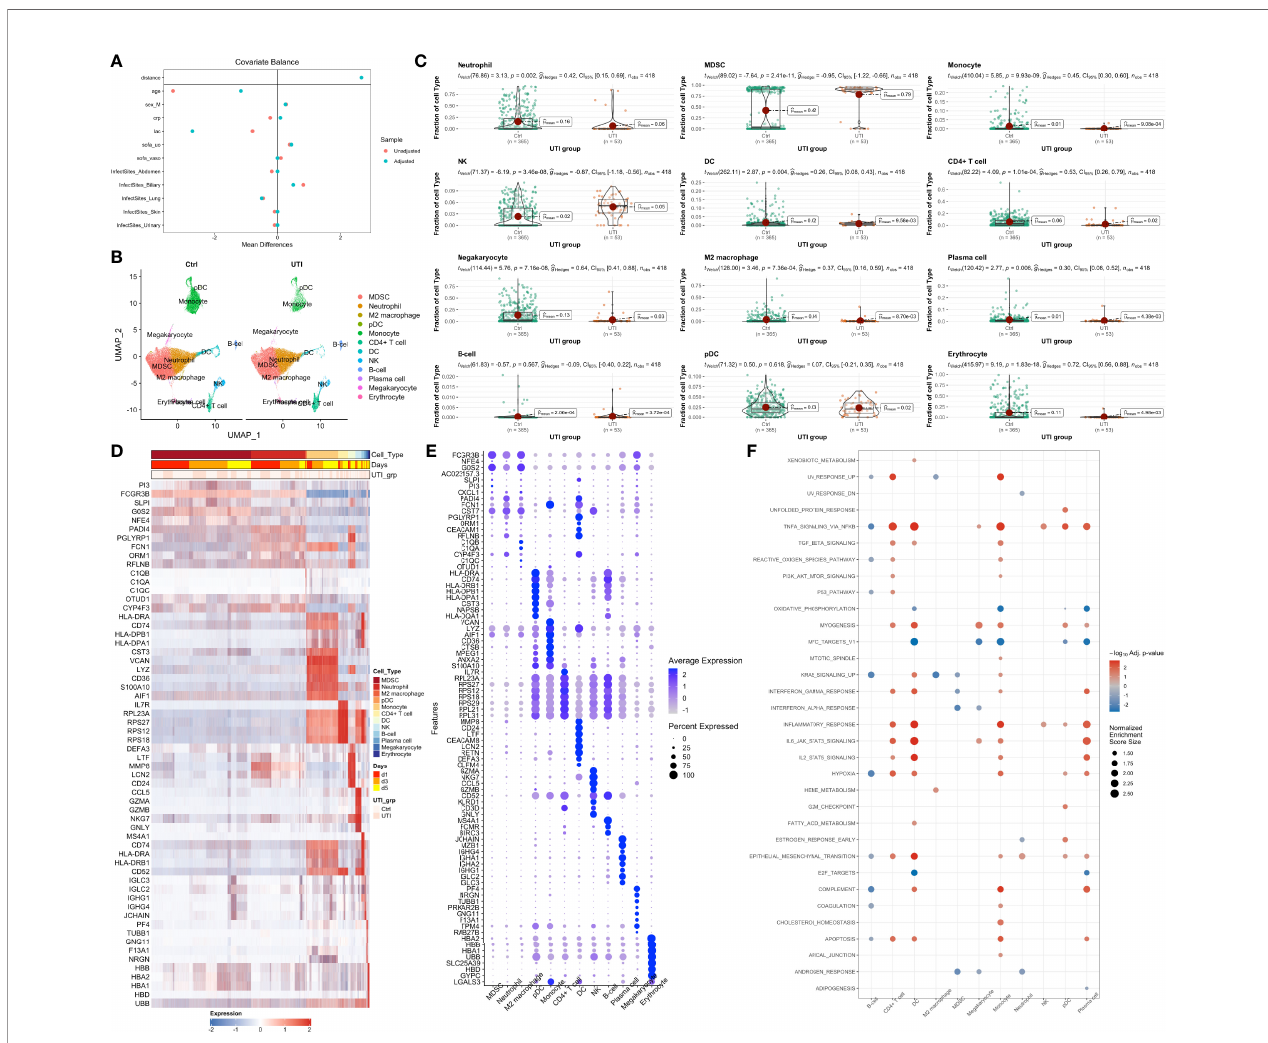
FIGURE 5 | Single cell RNA-seq analysis in UTI and control samples. (A) balance diagnostics of propensity score matching for samples with and without UTI administration. (B) Uniform manifold approximation and projection (UMAP) of single cell gene expression pro fi le, strati fi ed by UTI groups. Twelve cell types were identi fi ed for the 103,870 cells. (C) Comparisons of the cell type fractions between UTI and control groups. Cell type fractions of the bulk RNA-seq samples were inferred by deconvolution methods. The effect size of ^ g hedge is calculated by dividing the mean difference with pooled standard deviation. (D) Heatmap and (E) dot plot showing the marker genes of each cell type. (F) Gene set enrichment analysis of the differentially expressed genes between UTI and control groups across all cell